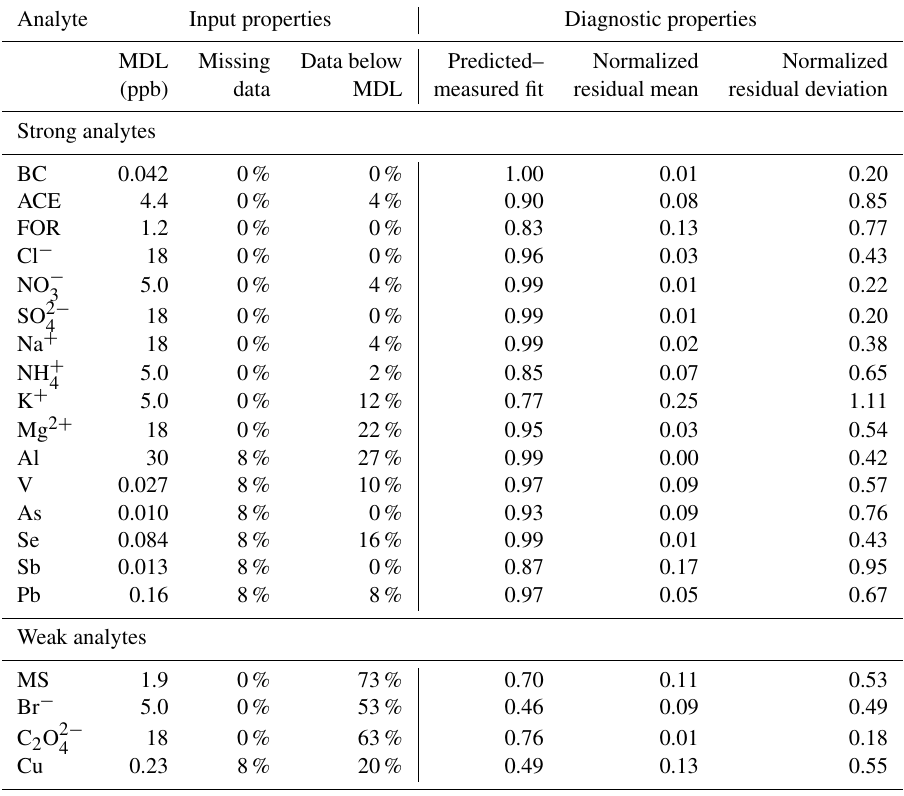
Table 1. Overview of PMF seven-factor solution input and diagnostic properties. Analyte Input properties Diagnostic